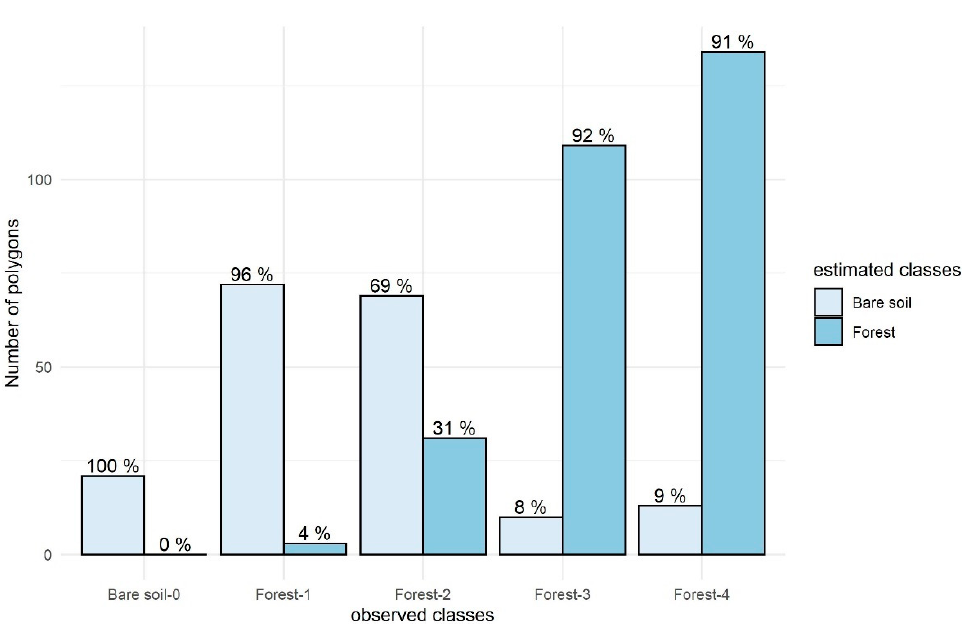
Figure 2. Results of the forest/non-forest binary classification of the 2018 dual-pol SAR image, with respect to the poplar stands age classes reported by the 2018 ground survey. Table 1. Overall accuracy (OA) and F-score for the classification of 4 poplar age classes with MARS and Random Forests models. The predictors contributing >20% to the result are reported in italic.